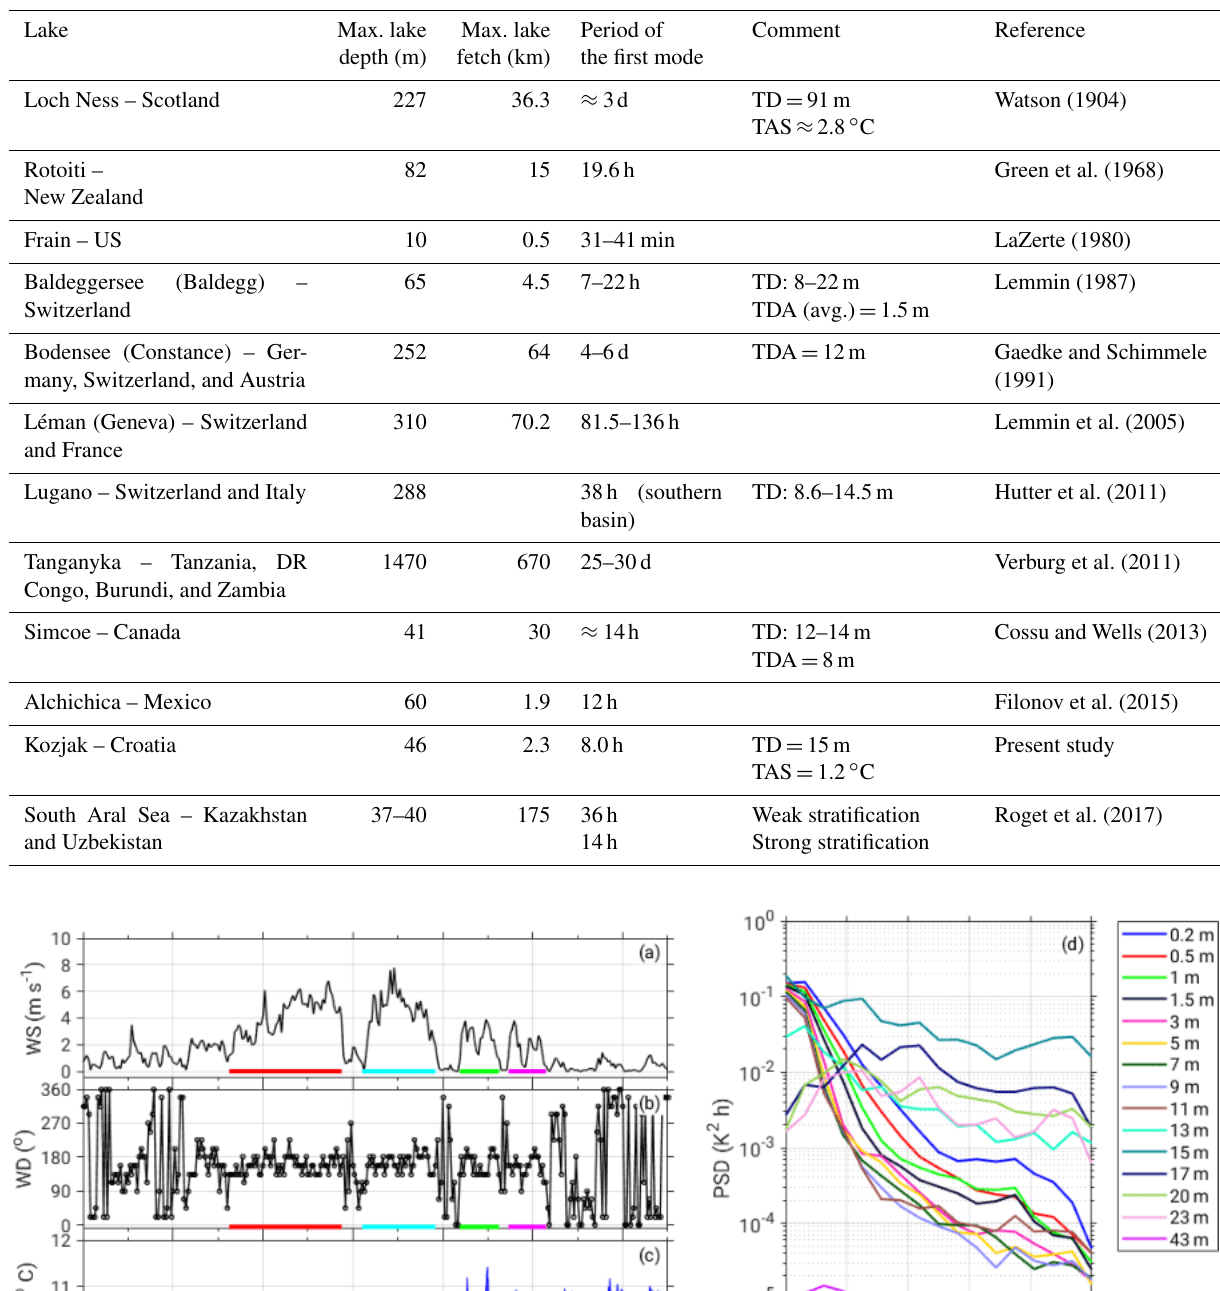
Table 1. Observed internal seiches (first horizontal mode) reported by various authors. TD, TDA, and TAS correspond to the reported thermocline depth (m), thermocline depth amplitude (m), and temperature amplitude of a seiche ( ◦